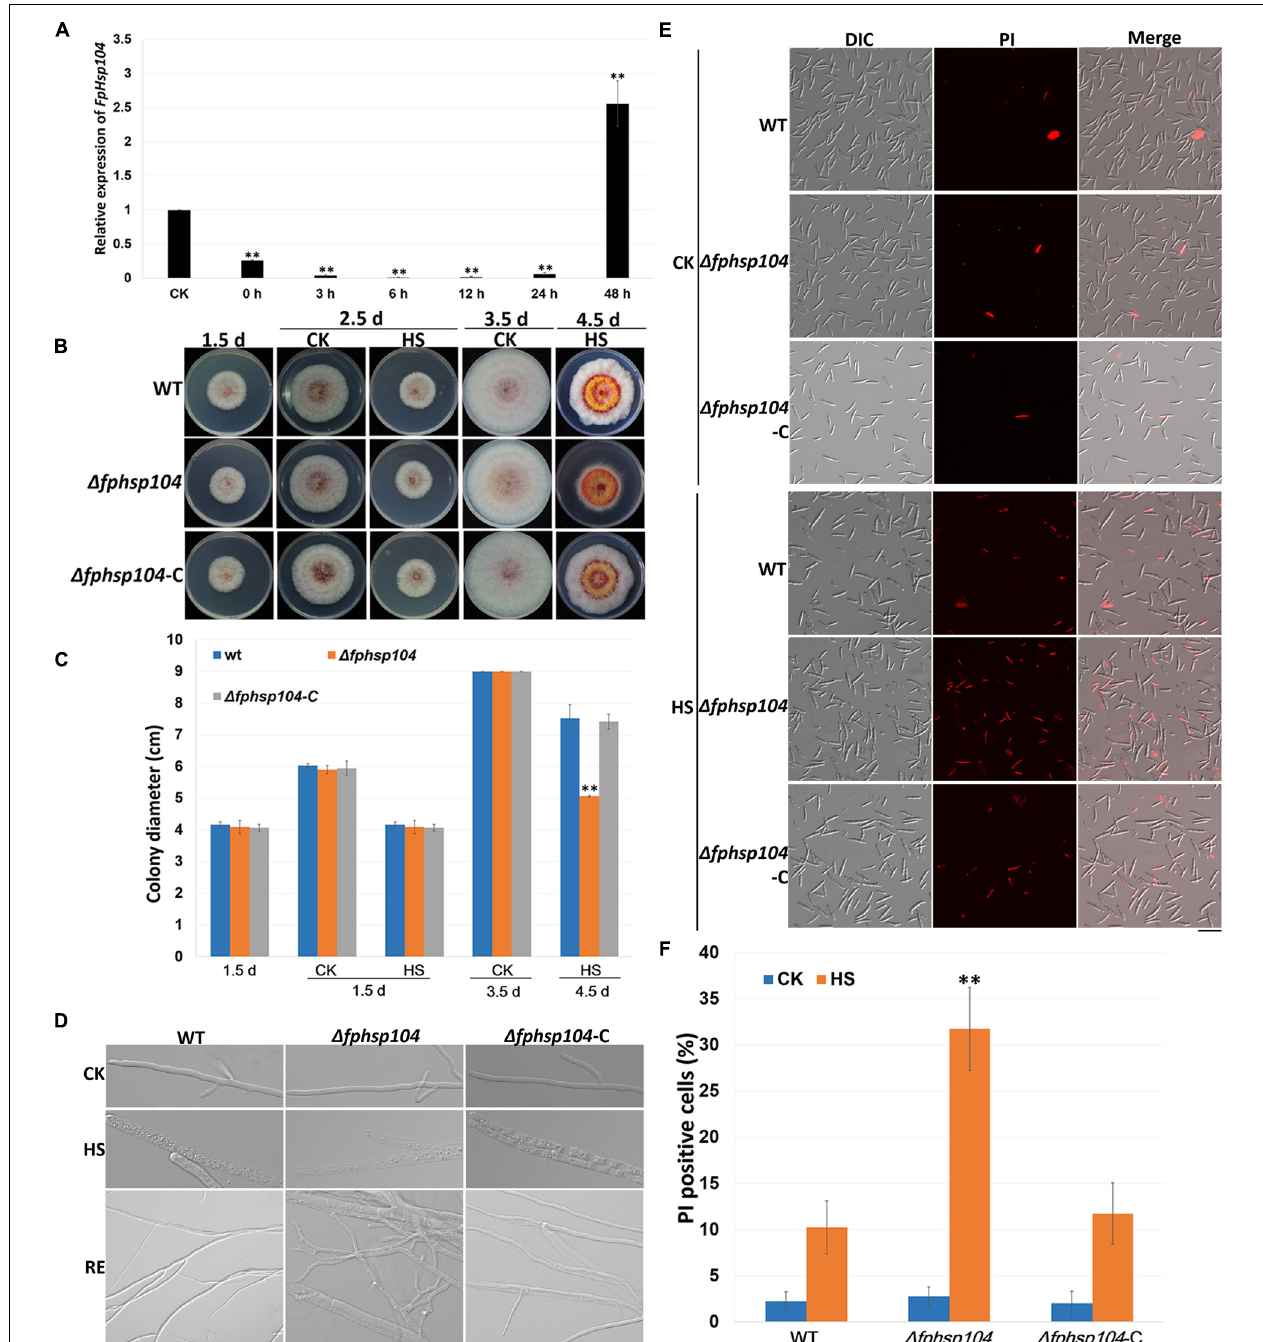
FIGURE 3 | Heat-shock-tolerance assays. (A) Relative expression levels of FpHsp104 in Fusarium pseudograminearum wild-type (WT) strain cultured in YEPD at 25 ◦ C for 12 h (CK), exposed to 34 ◦ C for 1 h, and returned to the optimal temperature (25 ◦ C) for 0–48 h. Expression levels represent FpHsp104 mRNA levels relative to those of FpTEF1a gene. Bars represent standard deviation based on four replicates. ∗∗ p < 0.01, ∗ p < 0.05 ( t -test). (B) Phenotypes of WT, (cid:49) fphsp104 , and (cid:49) fphsp104 -C strains cultured on potato dextrose agar (PDA) at 25 ◦ C for 1.5 days, 2.5 days (CK), and 3.5 days (CK); exposed to 34 ◦ C for 1 day (2.5 d-HS); and returned to the optimal temperature (25 ◦ C) for 2 days (4.5 d-HS). (C) Statistical analysis of colony diameter. Colony diameter is presented as the mean ± standard deviation of at least three independent experiments. ∗∗ p < 0.01, ∗ p < 0.05 ( t -test). (D) Hyphal morphology of WT, (cid:49) fphsp104 , and (cid:49) fphsp104 -C strains cultured on PDA at 25 ◦ C (CK), exposed to 34 ◦ C for 1 day (HS), and returned to 25 ◦ C for 2 days (RE). Bar = 20 µ m. (E) Propidium iodide (PI) staining of WT, (cid:49) fphsp104 , and (cid:49) fphsp104 -C conidia exposed to high temperature (34 ◦ C) (HS) or not (CK). PI-positive cells showed red fluorescence. (F) PI-positive cell numbers of WT, (cid:49) fphsp104 , and (cid:49) fphsp104 -C strains, exposed to 34 ◦ C (HS) or not (CK). Bars show mean values with standard deviation. ∗∗ Significant difference at p < 0.01 using t -test.